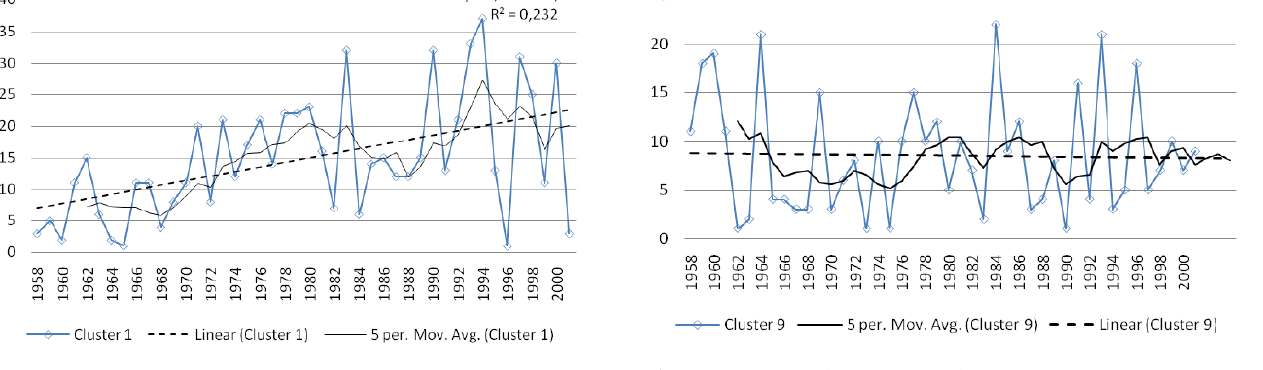
Fig.7. Frequency of appearance of Cluster 1, a 5-year moving average and a linear fit. Fig. 7. Frequency of appearance of Cluster 1, a 5-year moving av- erage and a linear fit.